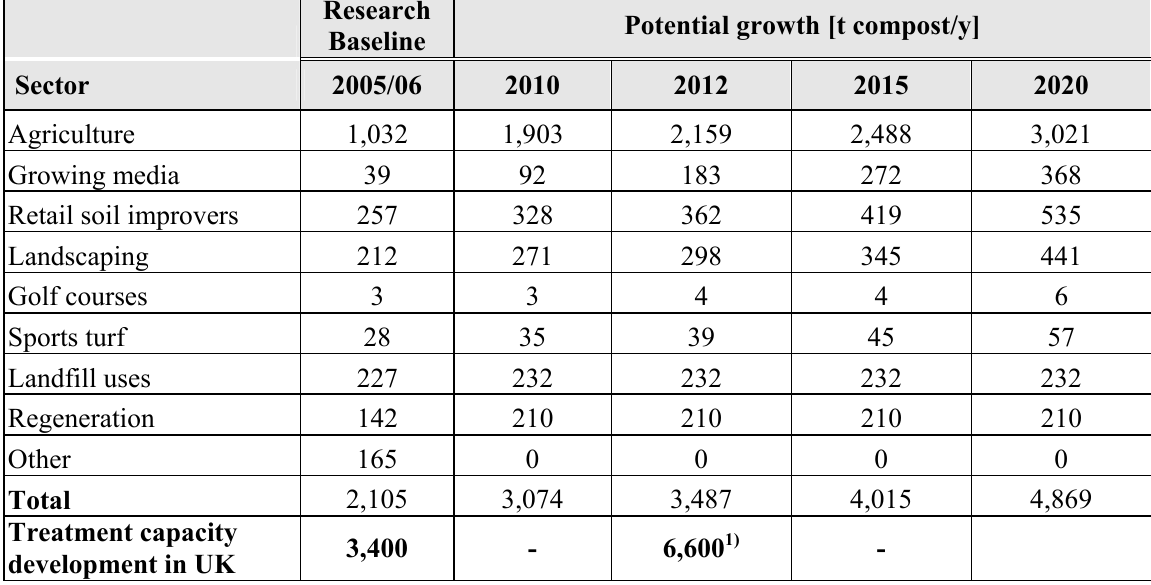
Table 45: Assessment of compost market development in UK in million t/y (Wallace,